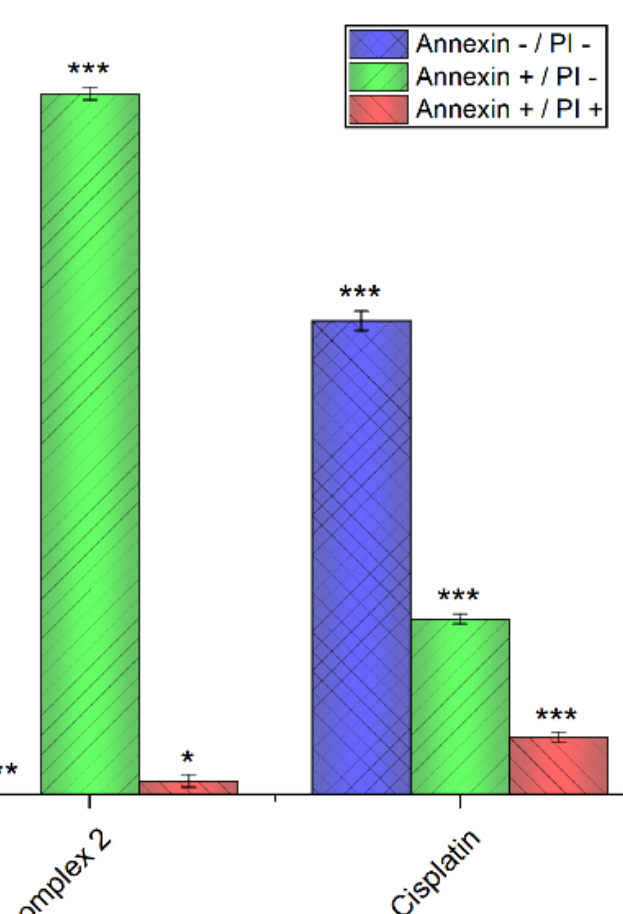
Figure 7. Activation of caspases 3/7 by complex 2 (applied at 3 µ M) and cisplatin applied to the A2780 cells at a 19 µ M concentration after 24 h of incubation. The significant change in the number of cells with activated caspases 3/7 compared to the untreated control is symbolized by ** at p ≤ 0.01 level, and *** at p ≤ 0.005 level. 3.7. Mitochondrial Membrane Potential Disruption In order to better understand the mechanisms leading to apoptosis in the A2780 cells caused by complex 2 , we performed the determination of mitochondrial membrane po- tential disruption by means of flow cytometry in the A2780 cells after 24 h of incubation (see Figures 8 and S24 in the Supplementary Materials). Interestingly, in contrast to cis- platin,